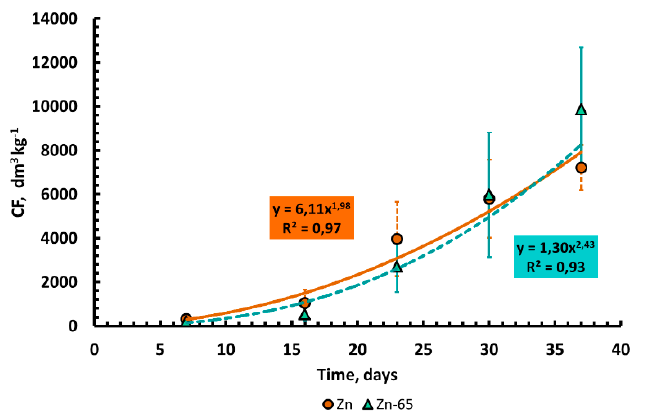
Figure 10. Dynamics of Zn( 65 Zn) concentration factors: CF Zn , and CF Zn-65 , dm 3 × kg − 1 in the dry vegetative mass of barley (mean values ± standard deviation; n = 3).